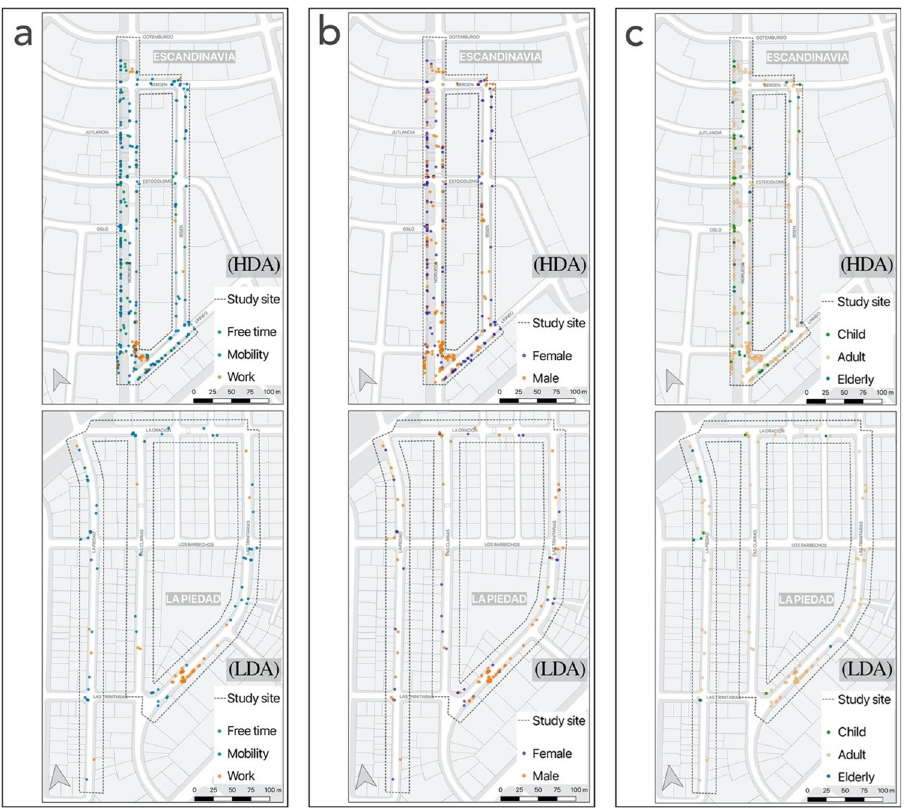
Fig 3. Spatial distribution according to activities (a), gender (b), and age group (c). Source : own production over Openstreetmap